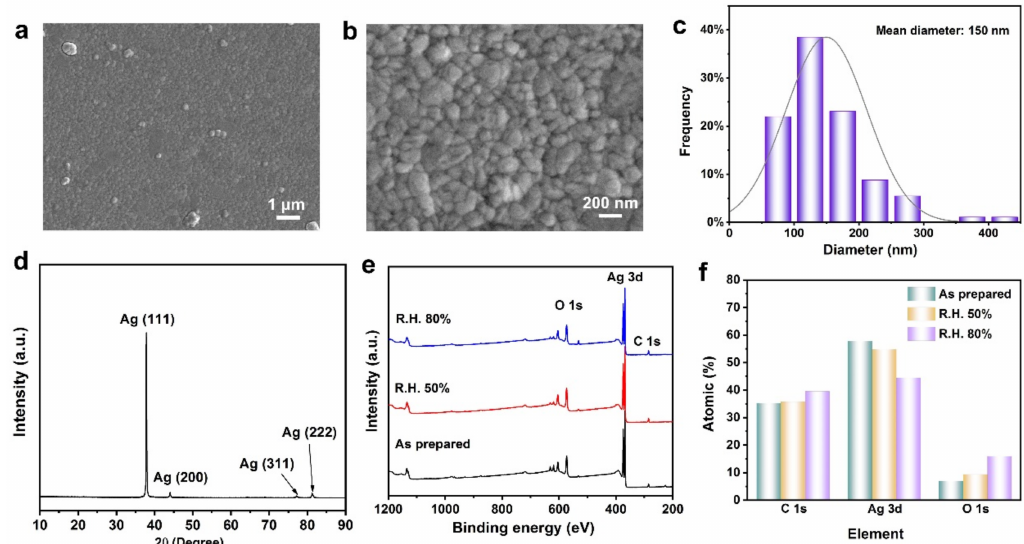
Figure 1. Characterization of the sputtered Ag. ( a , b ) The scanning electron microscopy (SEM) images of sputtered Ag with different magnifications; ( c ) Statistical analysis of the sputtered Ag size; ( d ) The X-ray diffraction (XRD) spectrum of Ag, including distinct characteristic peaks; ( e ) The survey X-ray photoelectron spectroscopy (XPS) of sputtered Ag, which is exposed at different ambient air and is mainly composited of C, O, and Ag; ( f ) The atomic percentage of sputtered Ag with different exposure